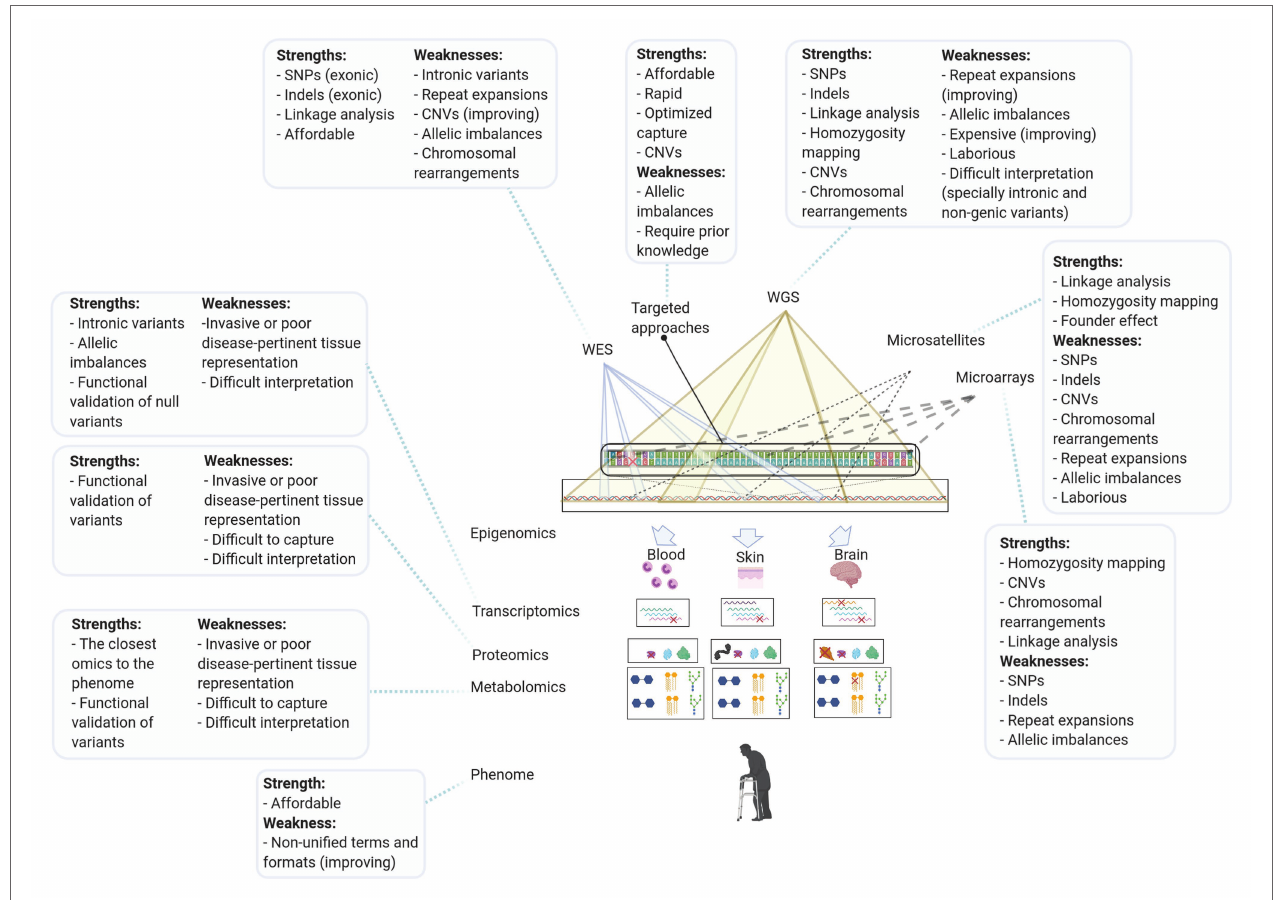
FIGURE 3 | The strengths and weaknesses of the methods used in diagnosing subtypes of hereditary SCD. WES, whole-exome sequencing; WGS, whole- genome sequencing; Targeted approaches, targeted next-generation sequencing, candidate gene approaches, and repeats expansion detection methods; SNPs, single nucleotide polymorphisms; and CNVs, copy number